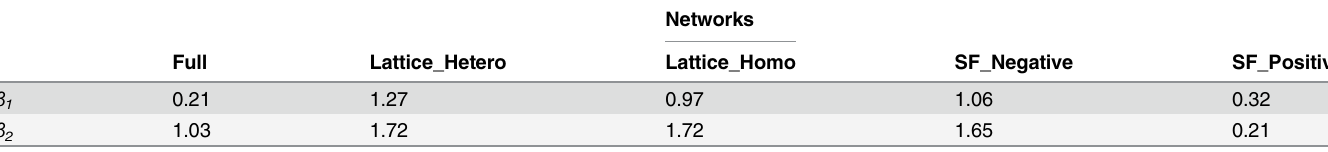
Table 3. Fitted Parameters of the Beta